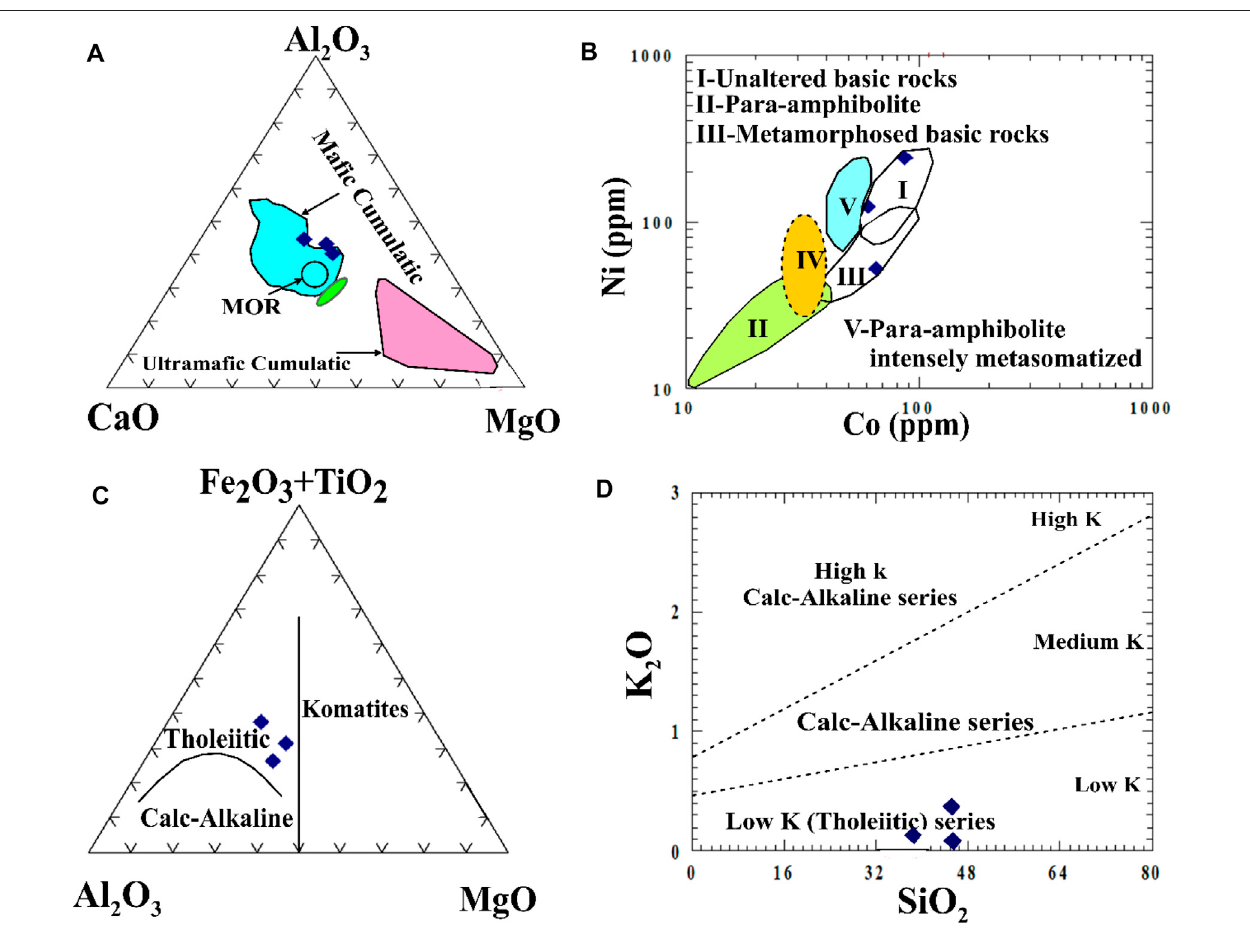
FIGURE11|(A) Al 2 O 3 -CaO-MgOternarydiagramfortheamphiboliterocks(Coleman,1977). (B) NiversusCoforthepresentamphibolitesrocksafterWalkeretal. (1960) and Heier (1960). (I) unaltered and slightly altered basic magmatic rocks. II- Para-amphibolites of low to moderate grade alteration, including metasomatism. III- metamorphosed basic magmatic rocks (metadolerites and metabasalts). IV- Ortho-amphibolites intensely metasomatized. V- Para-amphibolites, intensely metasomatized. (C) (Fe 2 O 3 +TiO 2 ) – Al 2 O 3 MgOdiagramforthestudiedamphiboliterocks(Jensen,1976). (D) K 2 OversusSiO 2 binarydiagramforamphiboliterocks (Le maitre et al.,